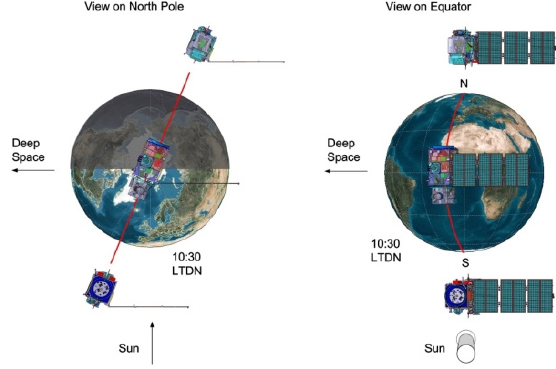
payload and has a push-broom configuration. The MSI sensor acquires in 13 different spectral band (Visible, NIR and SWIR) with a ground sample resolution (GSD) of 10 m for (B2, B3, B4 and B8) and a swat of 290 km.